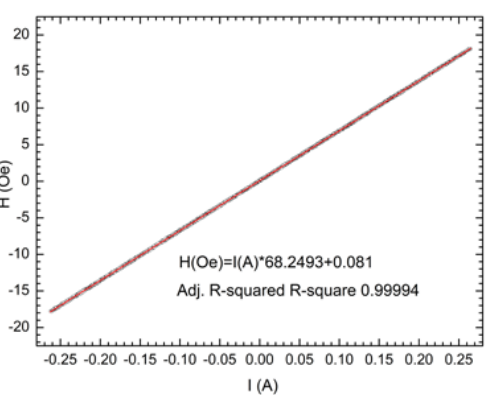
Figure 16. Helmholtz coil supply current-field dependency, H(I) characteristic in the sensor area.